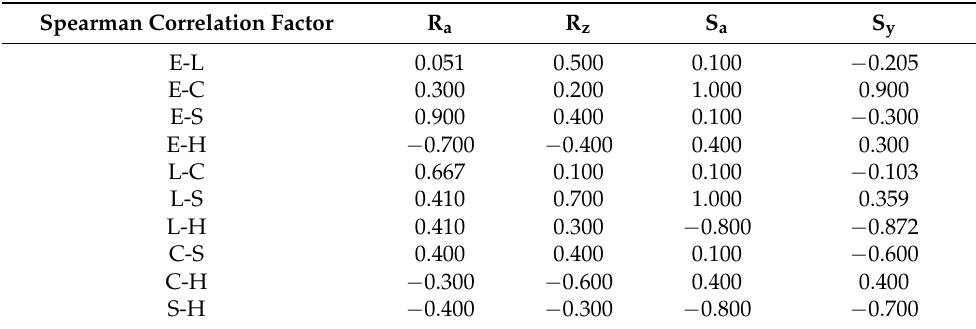
Table 9. Correlation factor values related to material, after finishing. E (Enamic), L (Lava Ultimate), C (Cerasmart), S (Shofu), H (Hyramic).